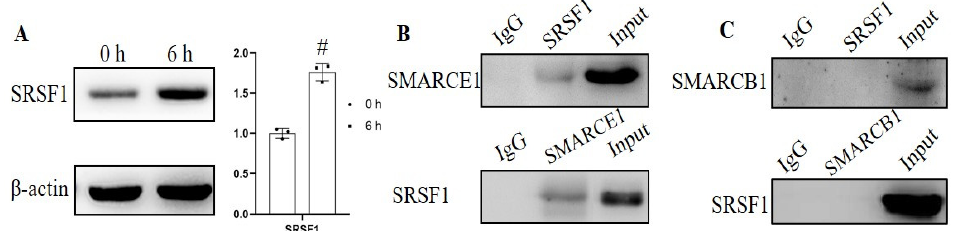
Figure 4. SMARCE1 interacted with SRSF1. ( A ) The SRSF1 expression was tested in HaCaT cells by Western blotting at 6 h after mechanical strain, and the bonds were quantified by Image J software. ( B ) Co-immunoprecipitation assay (Co-IP) confirmation of the interaction between SMARCE1 protein and SRSF1. ( C ) The interaction between SMARCB1 and SRSF1 was examined by Co-IP assay. Data present three sets of independent experiments. # p < 0.05 vs. the 0 hgroup.